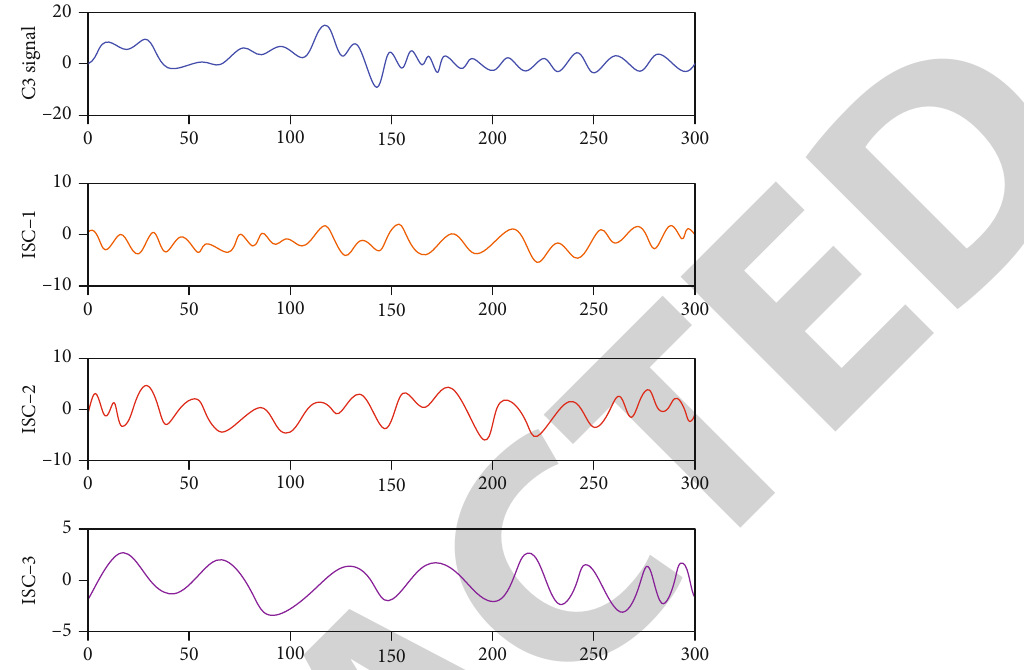
Figure 12: ISC component diagram of EEG signal of C3 channel after being decomposed by LCD.